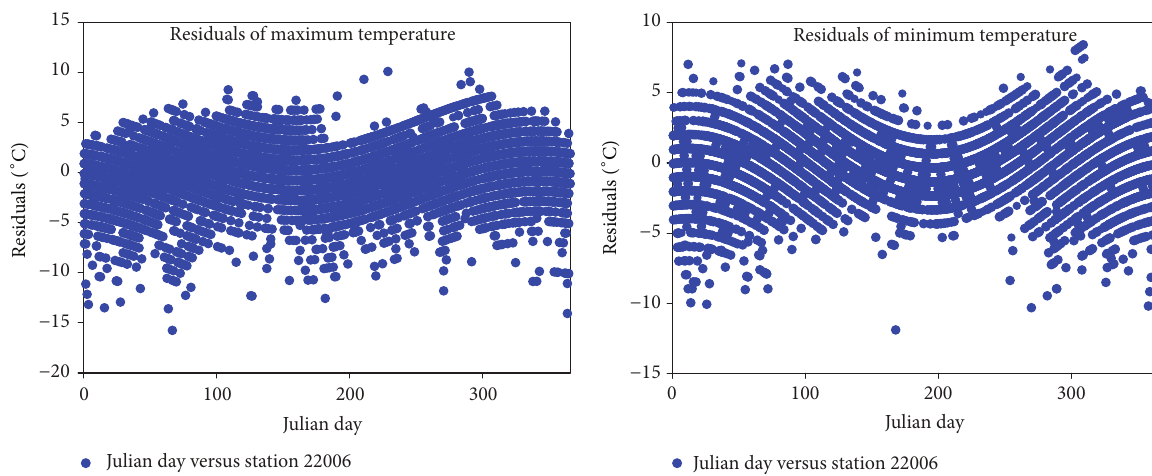
Figure 4: Residuals of maximum and minimum daily temperature for El Pueblito (ID 22006) weather station.